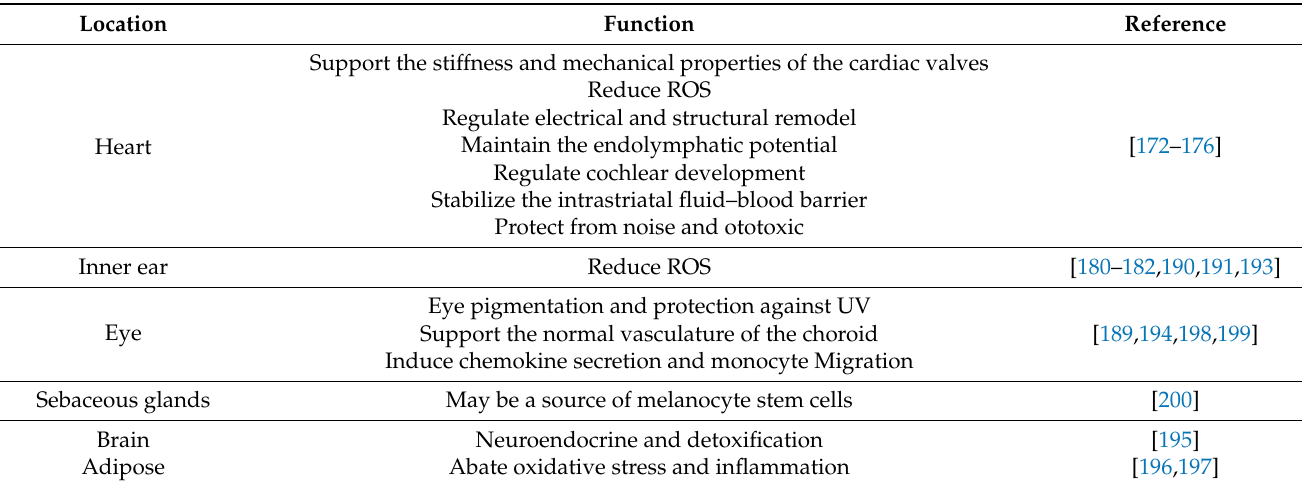
Table 2. Locations and Functions of Extracutaneous